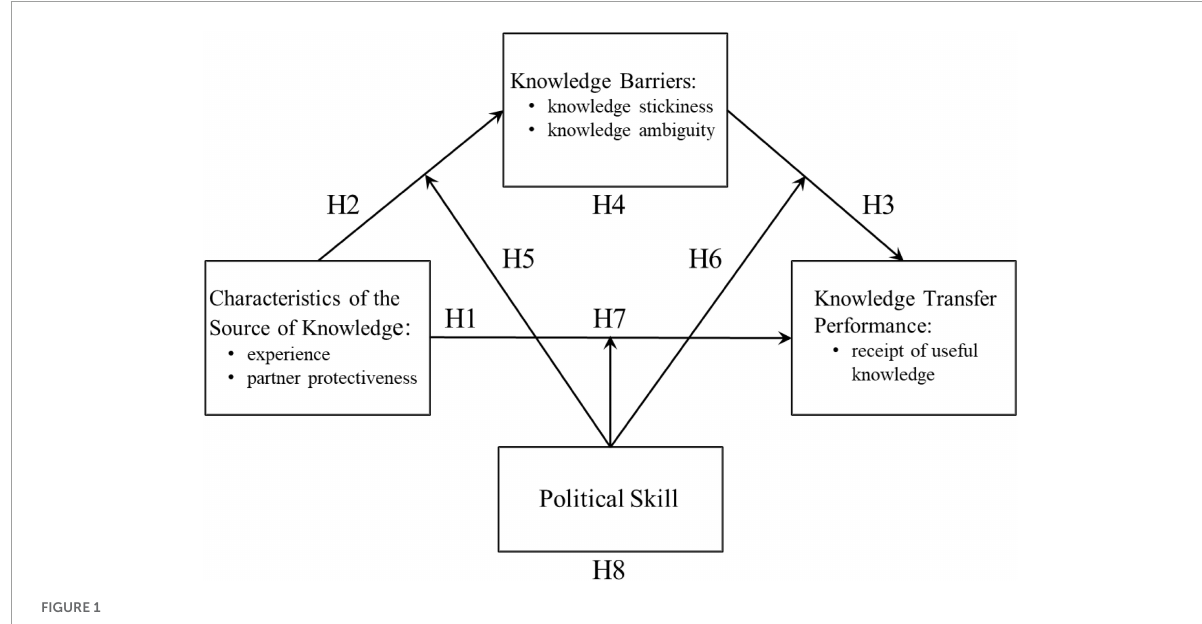
FIGURE1 Research